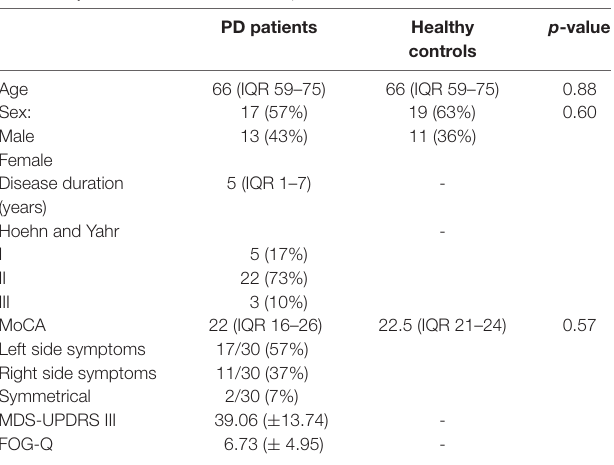
dataset C. Results showing the degree of false positive and false negative are shown for each model and each set of variables